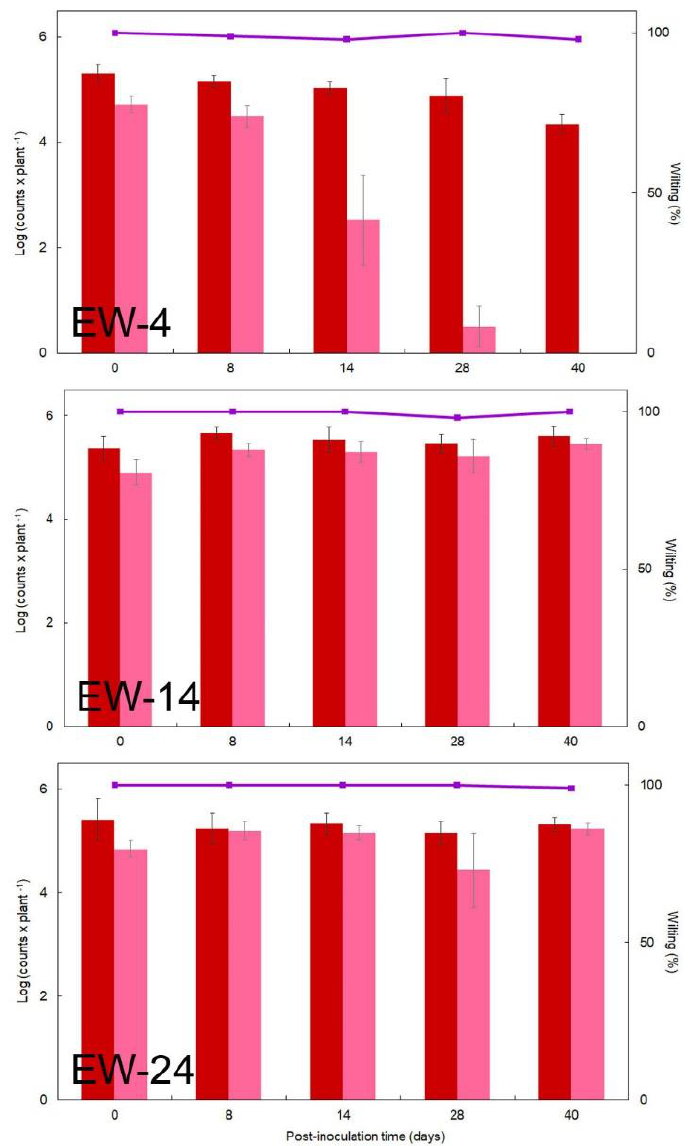
Figure 4. Pathogenicity of Ralstonia solanacearum strain IVIA-1602.1 previously starved in environmental water microcosms during 40 days, in tomato plants cv. ‘Roma’. Viable ( red bars ) and culturable ( pink bars ) cells per plant, and percentage of wilted plants ( ■ ). Only assays performed in at least weekly intervals from one representative environmental water (EW) at 4 °C (EW − 4), 14 °C (EW − 14) and 24 °C (EW − 24) have been plotted. Points are mean ± standard deviation (SD) of triplicate microcosms. Absolute value for 100% wilting refers to 24 plants (6 × 4 sets). At the three temperatures, SD of wilting values for most of the points was zero, and ± 2.0% in some cases. Control plants inoculated with freshly grown R. solanacearum strain IVIA-1602.1 developed 100% wilting, while those inoculated with PBS were negative.